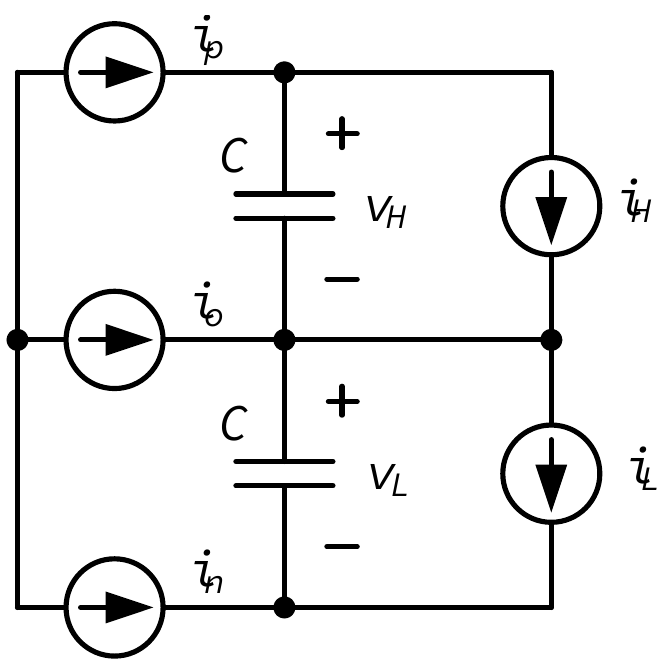
Figure 4. Equivalent circuit of output DC-link side. Through the balanced three-phase values, the following equation is satisfied.